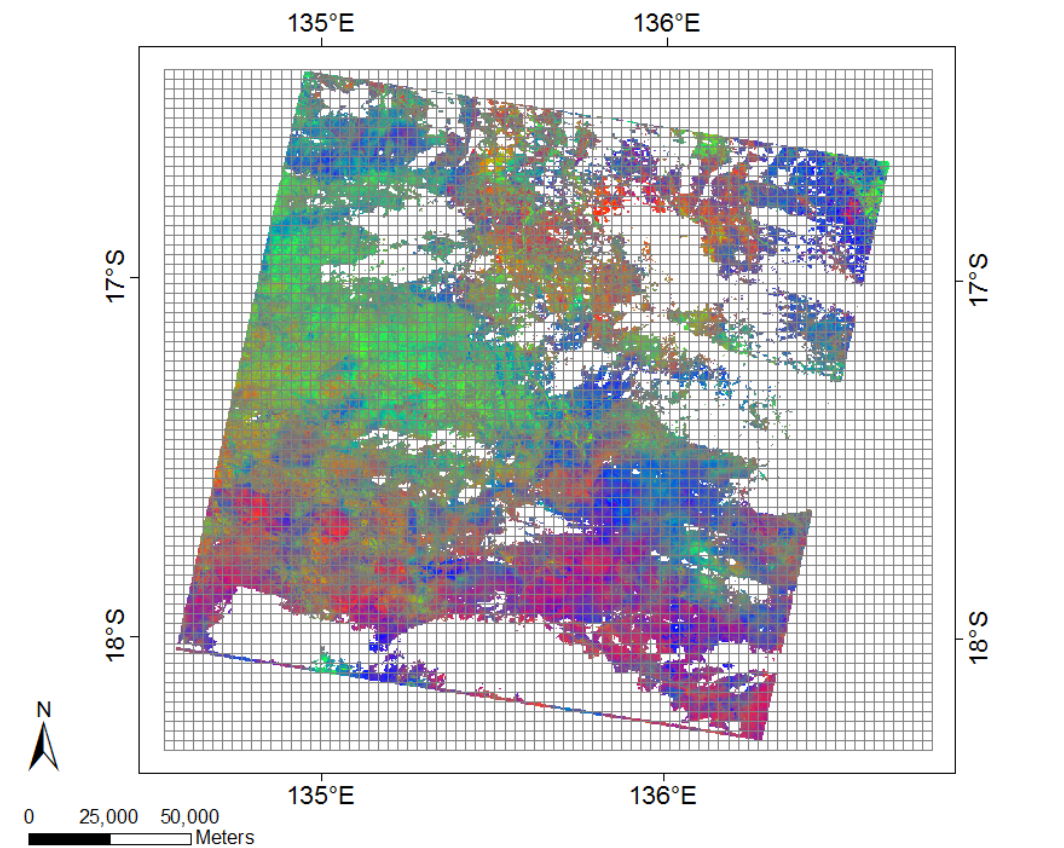
Figure 6. Spatial grid cells at a resolution of 3000 m. The total number of cells 5530. The FCover data are mapped to a even spaced grid where each grid cell contains 100 × 100 pixels and covers an area of 3000 × 3000 m. Please refer to Figure 3 for the triangular ternary diagram for the coloured relationships of the three ground cover